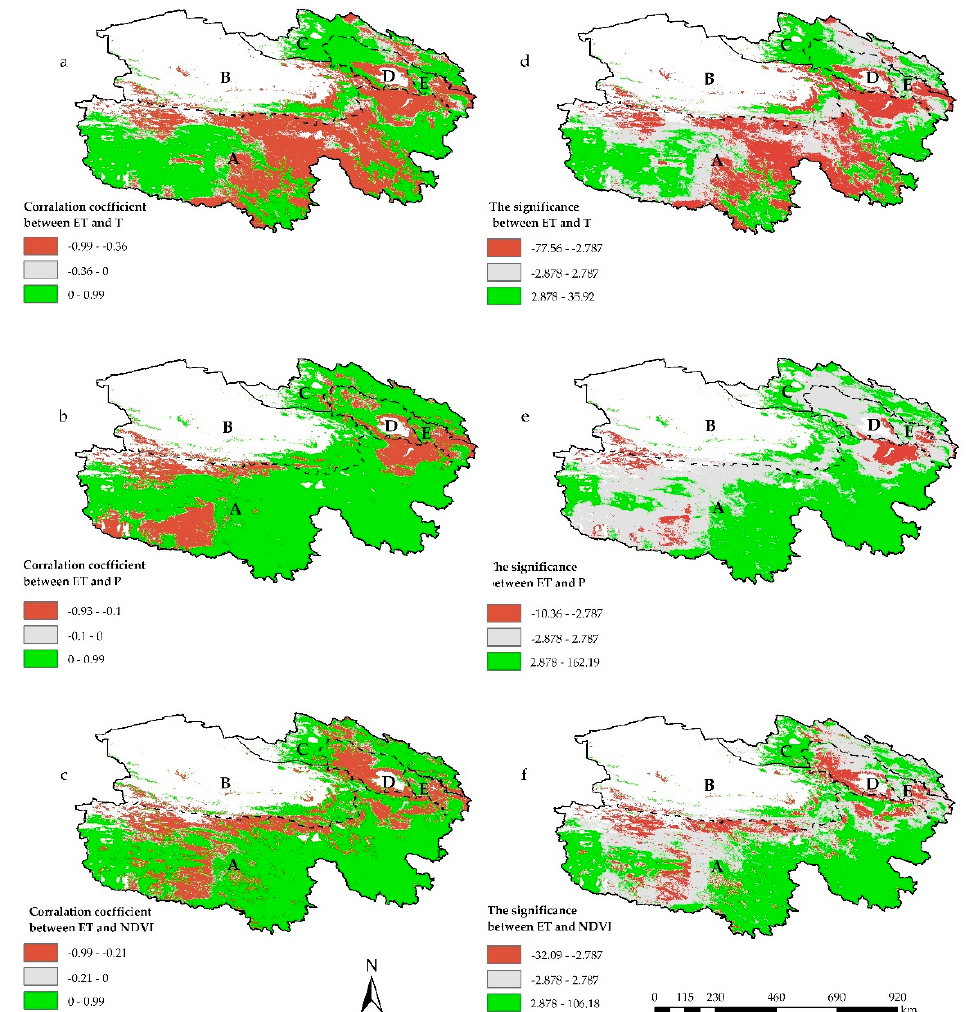
Figure 7. Spatial correlation coefficient distribution map of ET and T, P, and NDVI. ( a – c ) represent the correlation coefficient between ET and T, P, and NDVI; ( d – f ) represent the significance test between ET and T, P, and NDVI. A–E in the figure represents the Three-River Source region, the Qaidam Basin region, the Qilian Mountain region, the region around Qinghai Lake, and the Hehuang region,